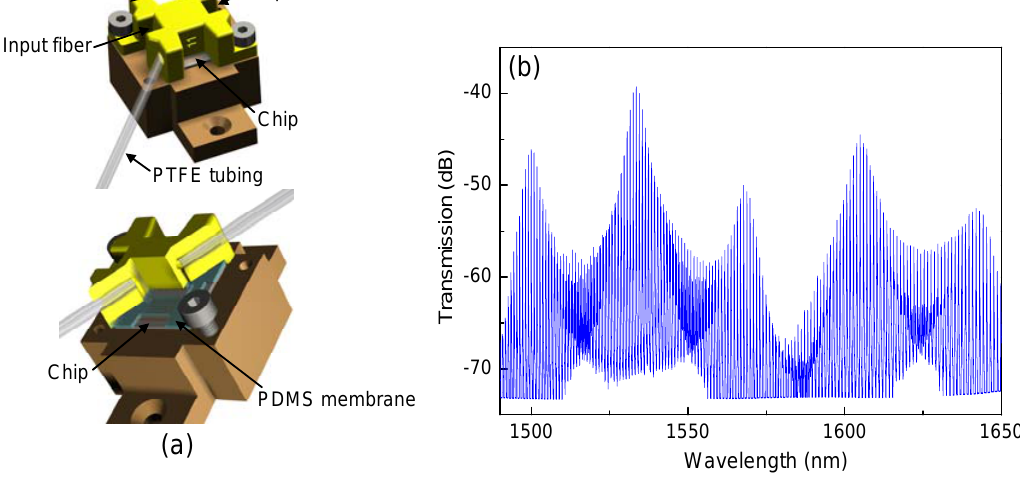
Figure 3. ( a ) Schematic diagram of the complete configuration of sensor chip and fluidic cell. ( b ) Transmission spectrum of the sensor when the sensor element is covered with